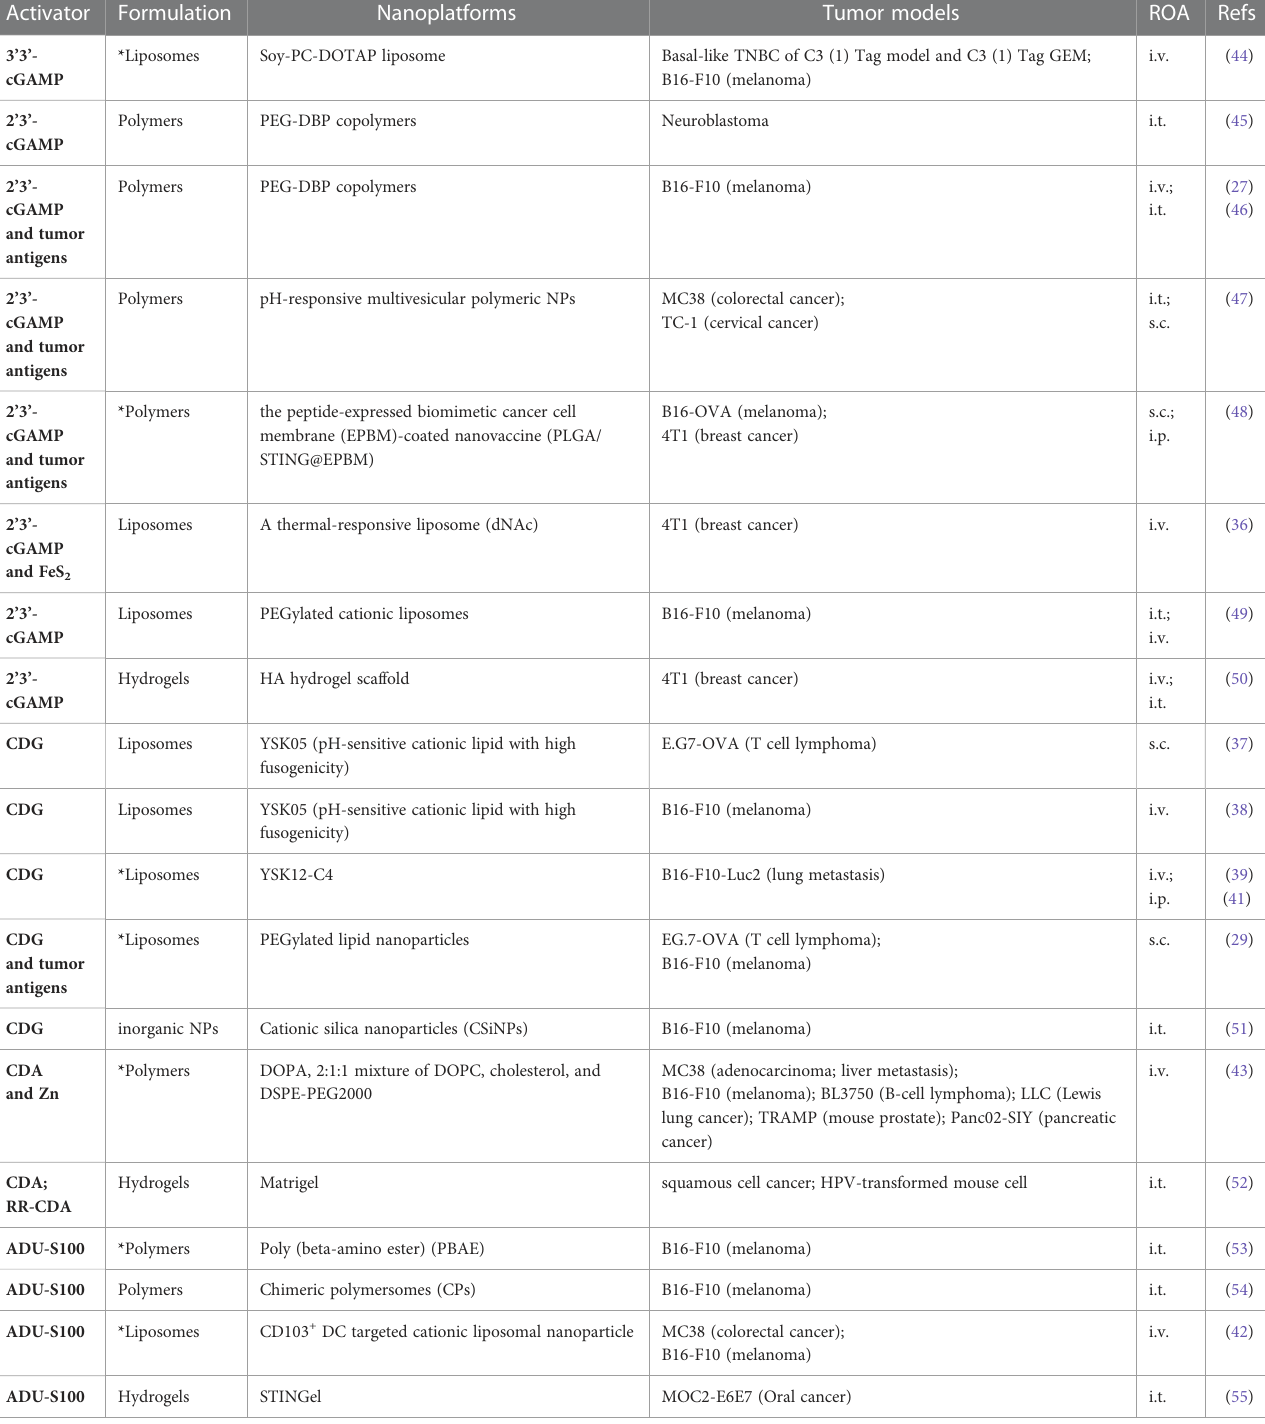
TABLE 1 Recent researches on nano-delivery of CDNs for tumor